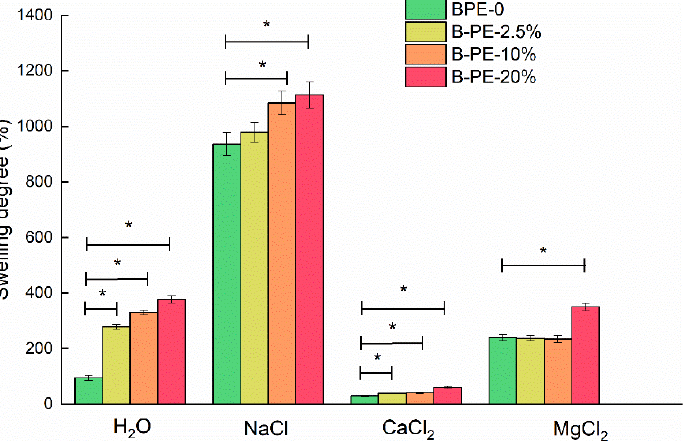
Figure 7. Swelling degrees of rice milk-based beads in salt aqueous solutions (* means that statistical